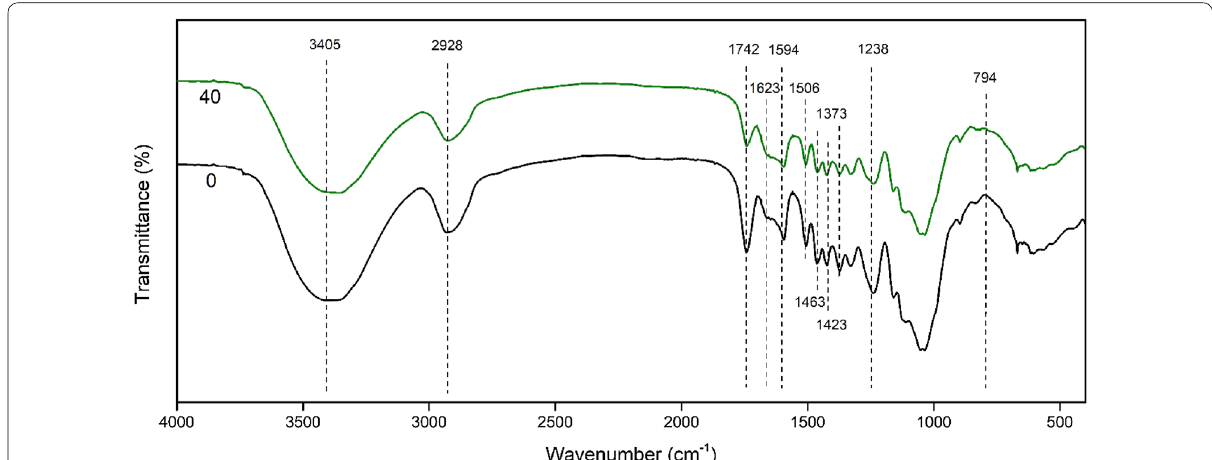
Fig. 3 FTIR spectra of rubberwood dyed with fungi at 0 and 40 days